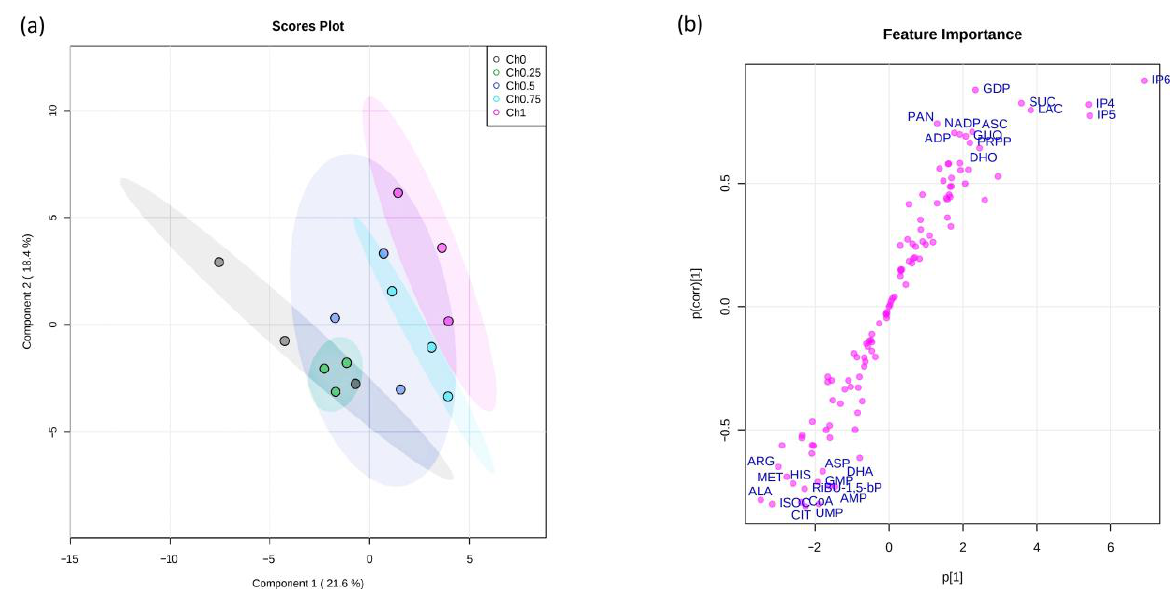
Figure 5. PCA and oPLS-DA score plots of tomato fruit metabolome from plants treated with different concentrations of chitosan (0, 0.25, 0.50, 0.75, and 1 mg mL −1 ). ( a ) PCA plots; ( b ) S-plot derived from oPLS-DA model between Ch0 and Ch1 groups. Table 3. Chitosan effects on the levels of sugars, vitamin E, lycopene, and flavonoids as well as the acquisition of